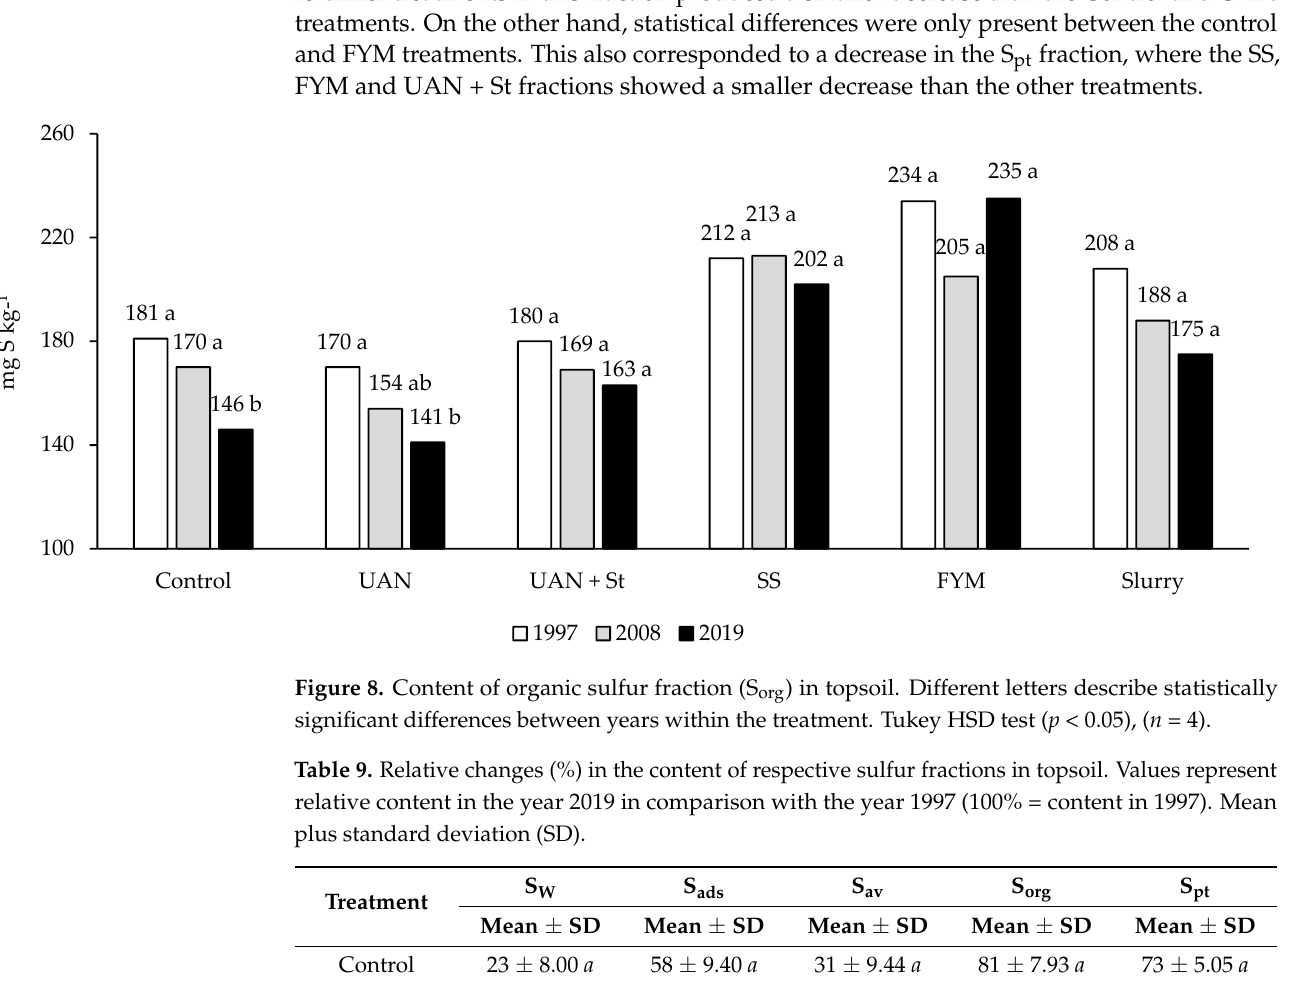
11 of 25 Figure 7. Content of pseudo - total sulfur fraction (S pt ) in topsoil. Different letters describe statisti- cally significant differences between years within the treatment. Tukey HSD test ( p < 0.05), ( n = 4).